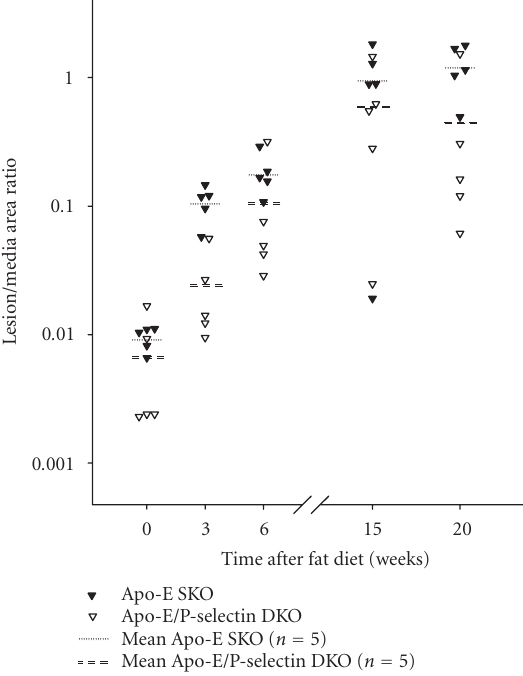
Figure 5: Lesion area in ApoE − / − (SKO) and ApoE − / − , P -selectin − / − (DKO) mice fed a fat diet . Ratios of lesion area over media area for SKO or DKO animals fed a fat diet, over 0 to 20 weeks. Individual values and means of SKO and DKO area ratios are shown for each